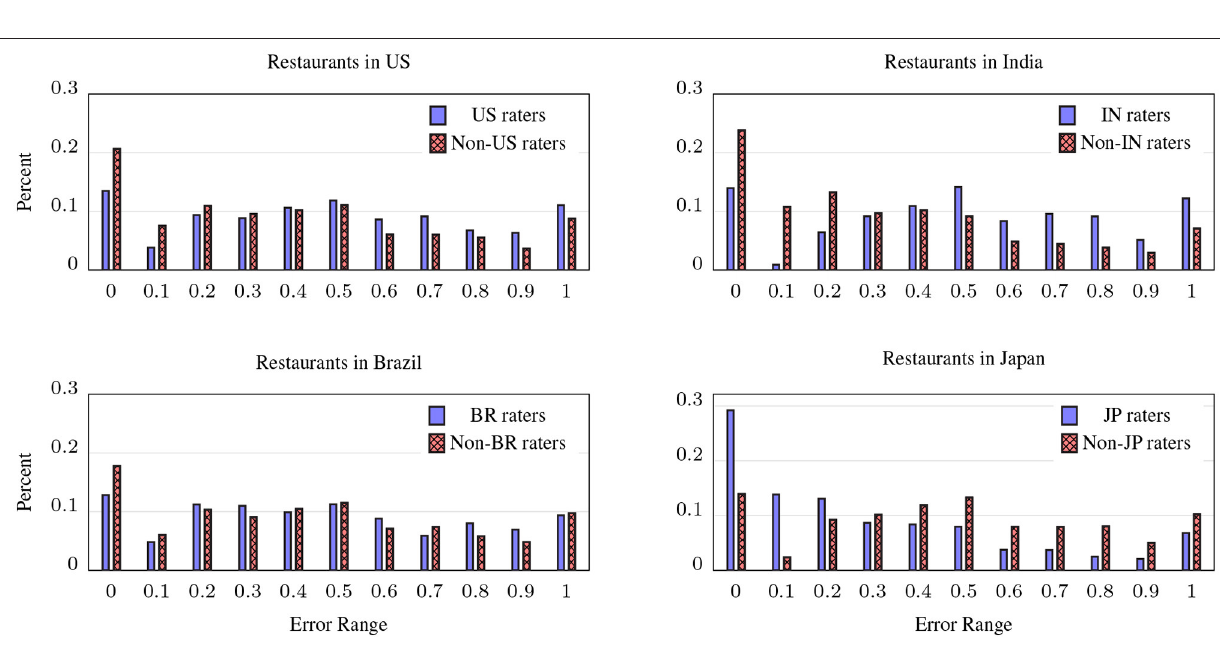
FIGURE 6 | Distribution of CrowdSense errors (Normalized-MAE) for ratings in four countries, comparing CrowdSense predictions from raters in each country to raters outside that country. A shift of scores to the left indicates lower overall error; surprisingly, for all countries except Japan, out-of-country CrowdSense raters are more accurate than those within the